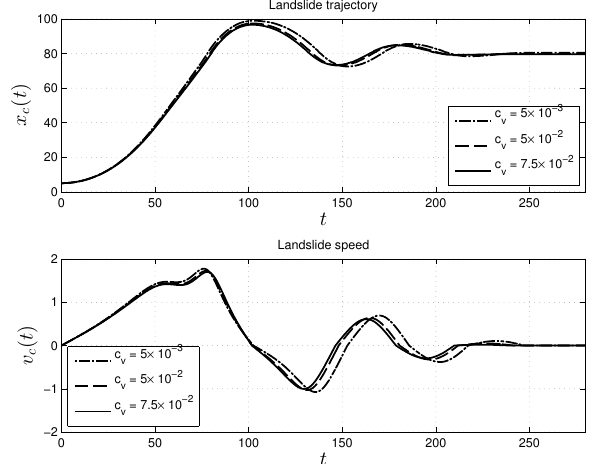
Figure 4. Position and velocity of the barycenter of the landslide as functions of Fig. 4. Position and velocity of the barycenter of the landslide as functions of dimensional time for three different values of the fric- dimensional time for three different values of the friction coefficient tion coefficient c v . c v .